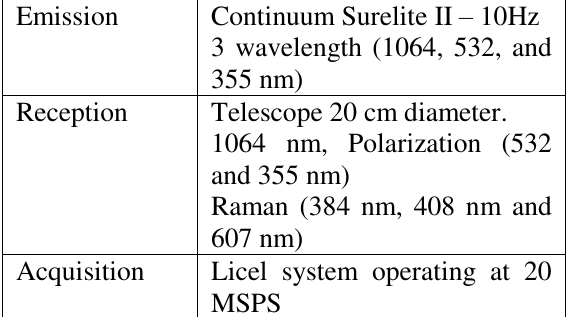
Table 1 Summarized characteristics of the Multi- wavelength Raman Depolarization Aerosol lidar installed in Punta